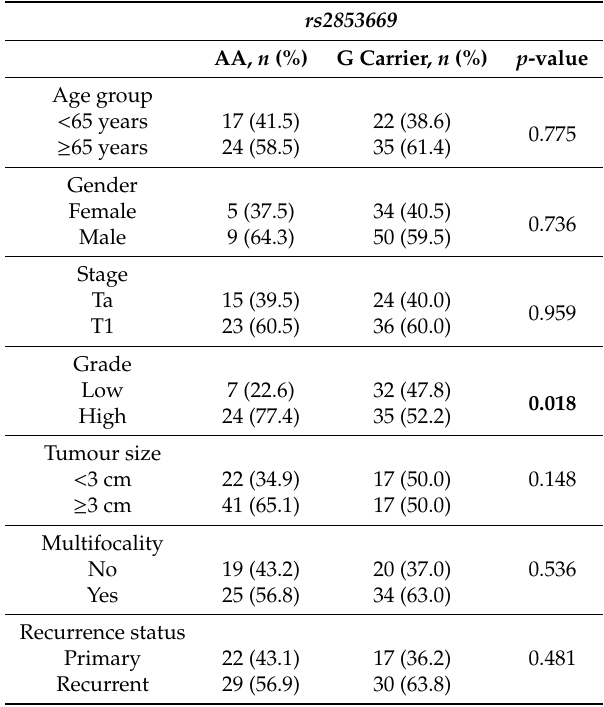
Table 3. Relation between clinicopathological data and rs2853669 single nucleotide polymorphism (SNP) status in